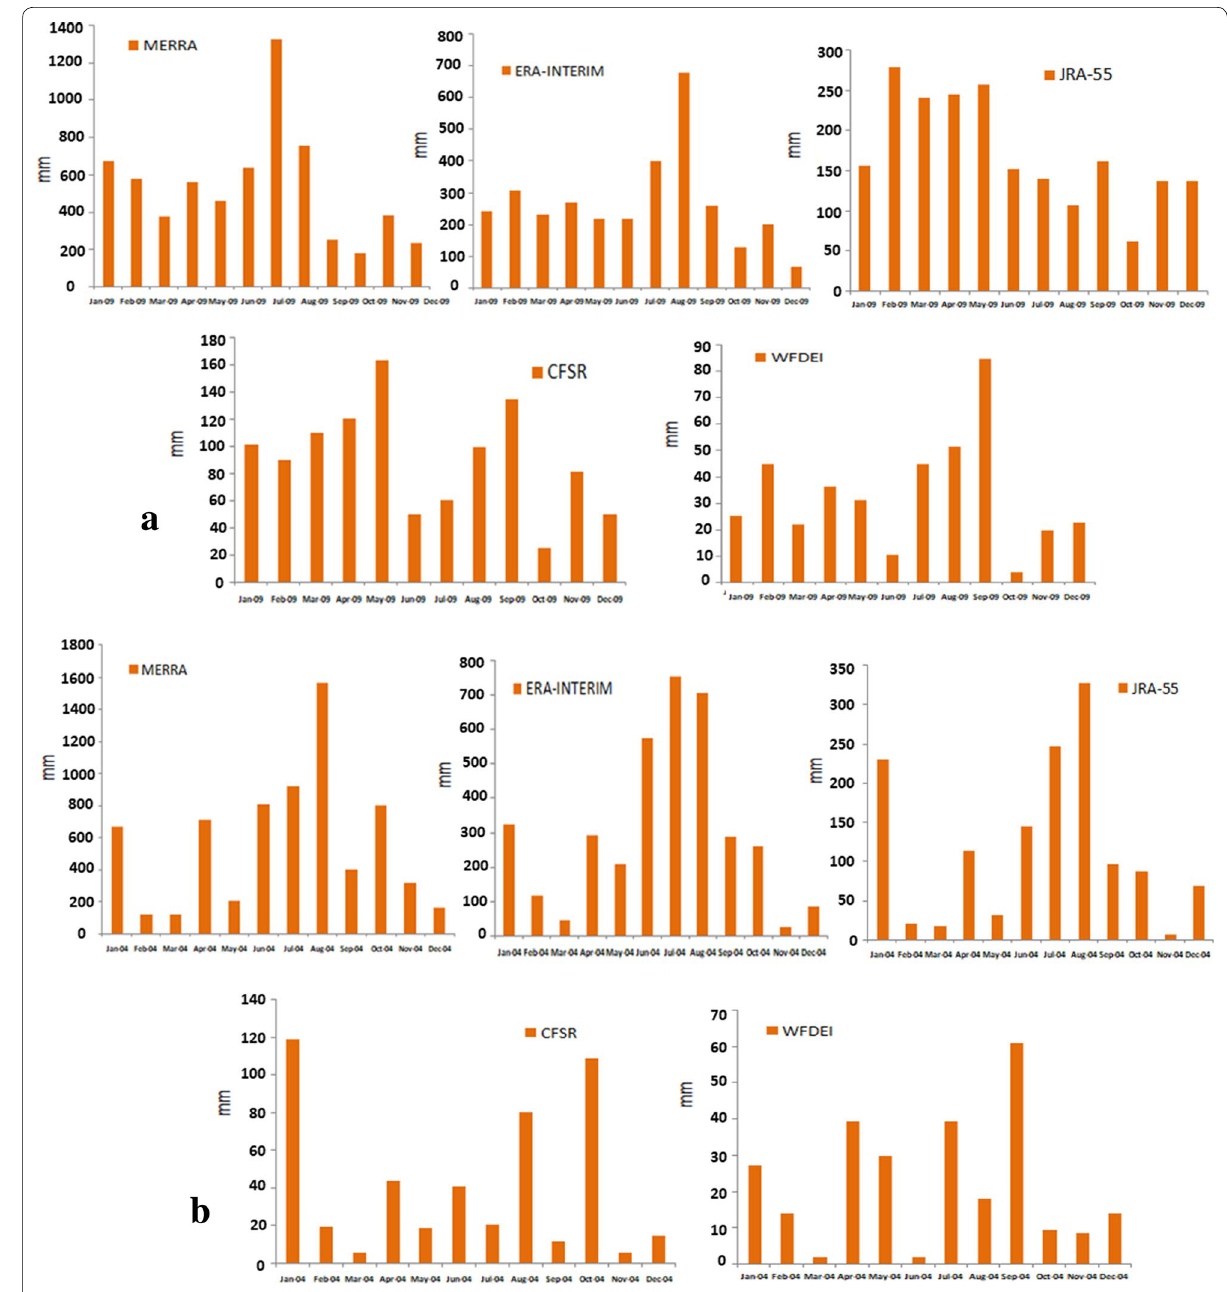
Fig.15 Monthly rainfall at ( a ) Manali for 2009 and ( b ) Larji for 2004 from different rainfall